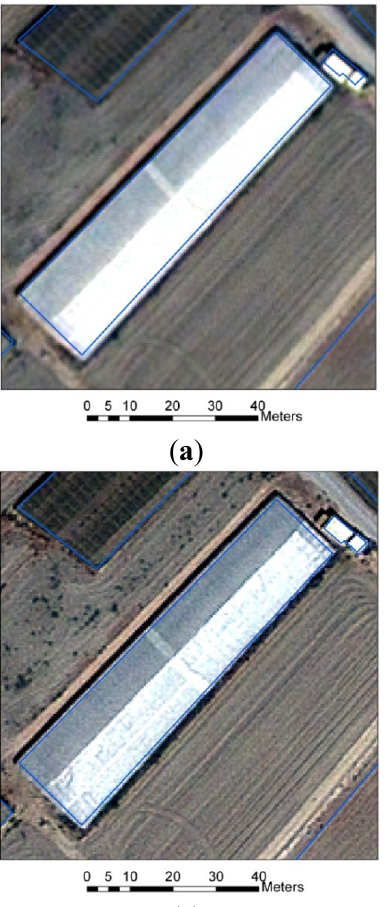
Figure 7. Pan-sharpened orthoimages showing a plastic greenhouse and a little